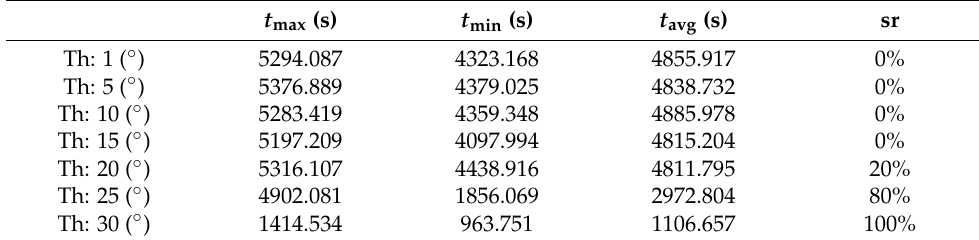
Table 1. Planning results of B-RRT*.